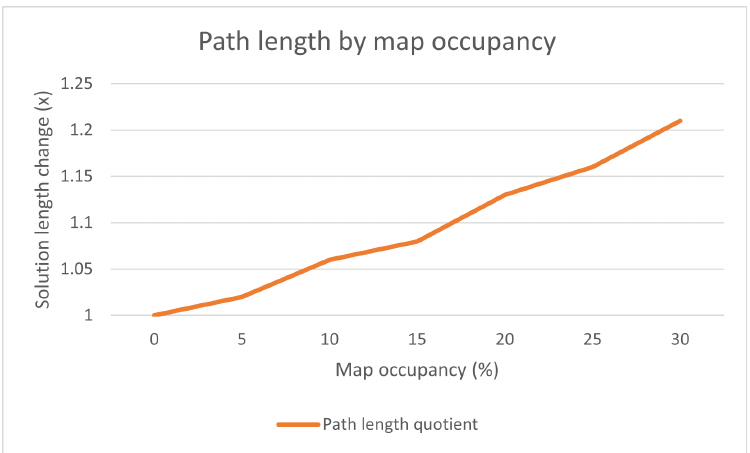
Figure 3. Measured difference in solution times on differently sized maps and different path